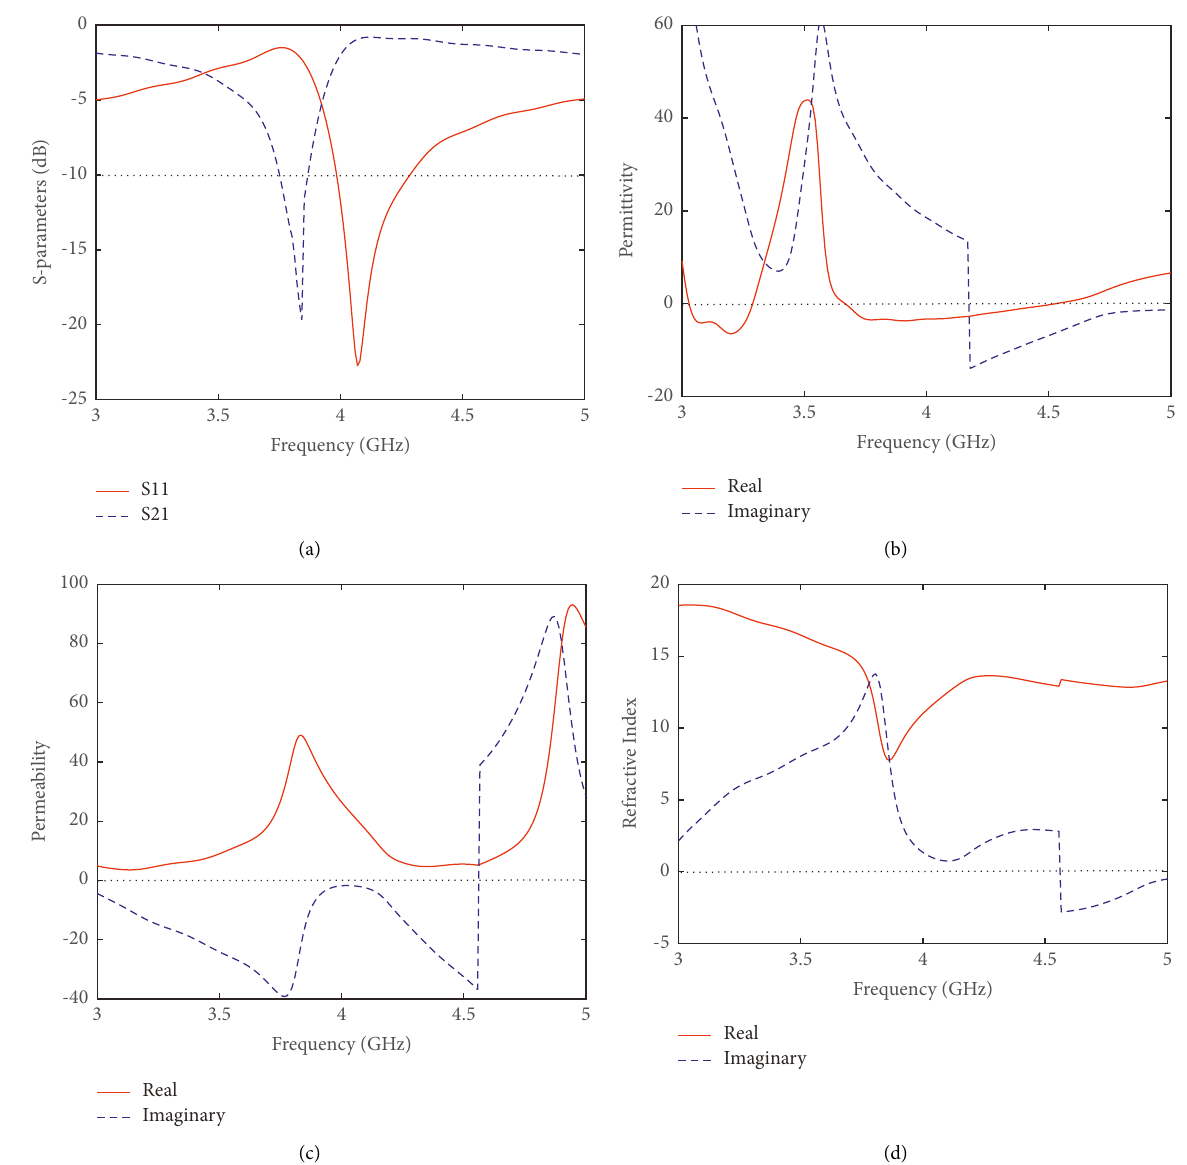
Figure 4: Proposed unit cell structure (a) S-parameters, (b) permittivity, (c) permeability, and (d) refractive